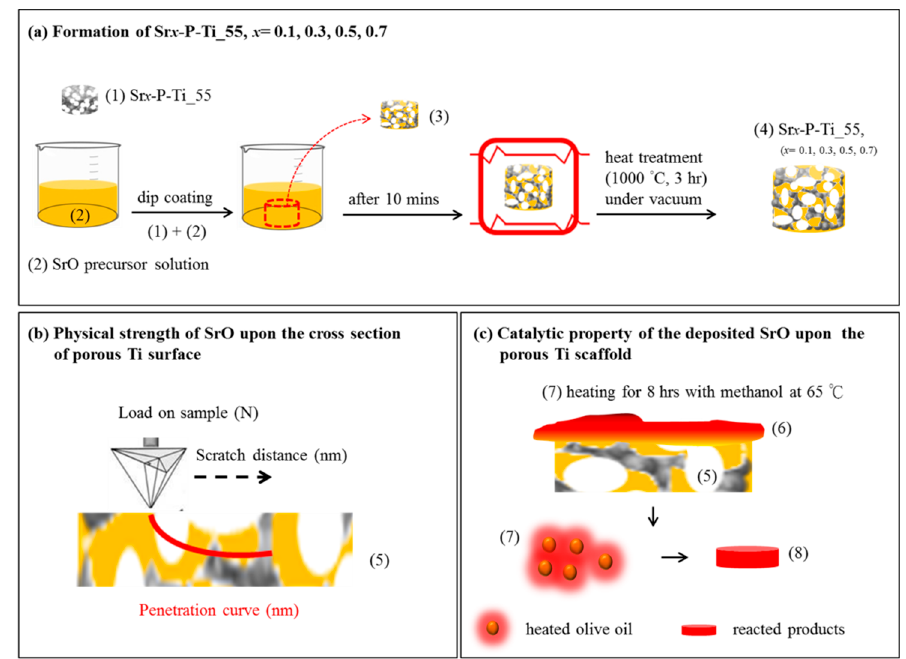
Figure 1. Schema for the formations of ( a ) SrO deposited upon a porous Ti scaffold (P-Ti): (1) the preparation of Sr x -P-Ti_55 ( x = 0.1, 0.3, 0.5, 0.7); (2) SrO precursor solution; (3) the samples